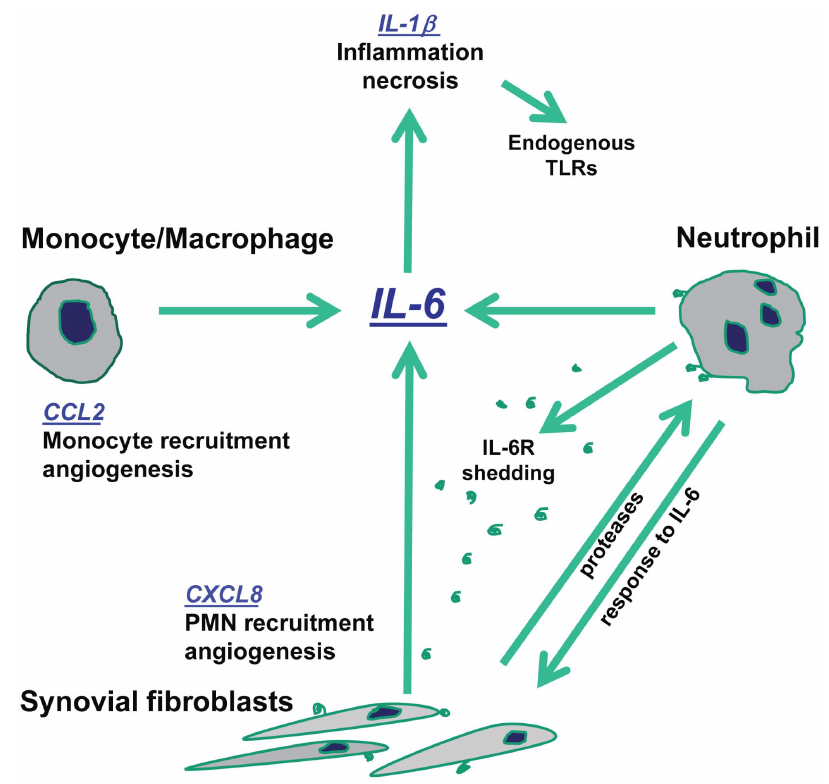
Figure 9. IL-6 amplifies the inflammatory response through a direct effect on stromal and innate immunity cells.